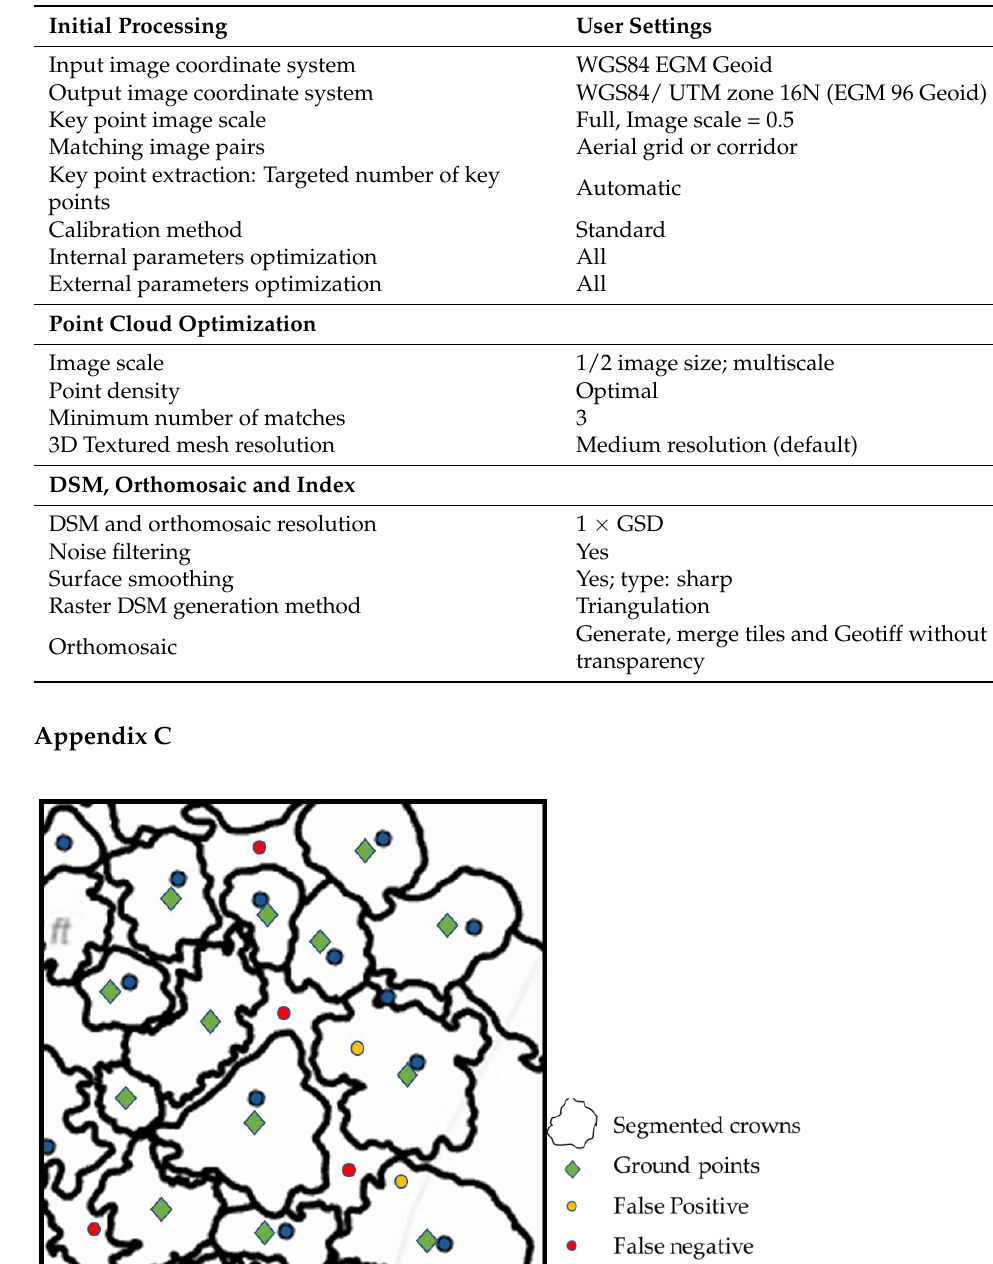
Table A2. Pix4D processing workflow settings for the datasets.